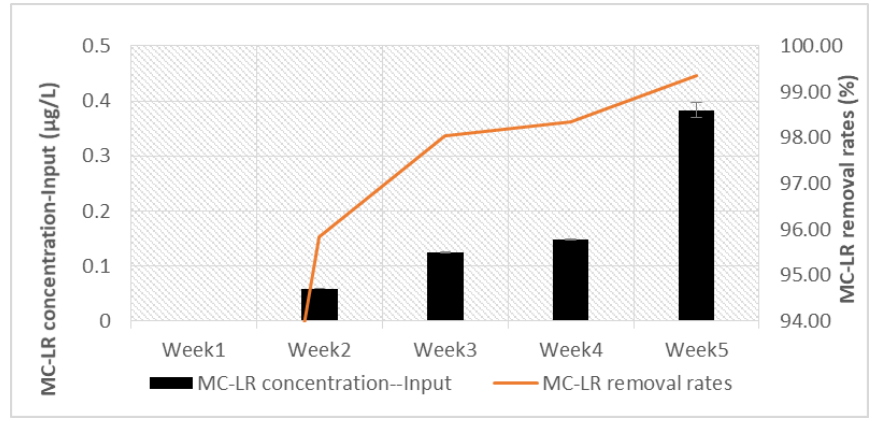
Figure 6. MC-LR removal rates by multi-soil-layering eco-technology during the experiment. Because the bloom used was characterized by the ELISA method, we worked with total microcystin concentrations. The analysis of water toxins was carried out at the Inter- disciplinary Center of Marine and Environmental Research (CIIMAR), Portugal, by LC – ESI-MS using a single standard MC-LR. Thus, the concentrations of MC-LR at the inlet and outlet were much lower than those of the microcystin equivalents used to prepare the distilled water contamination solutions.